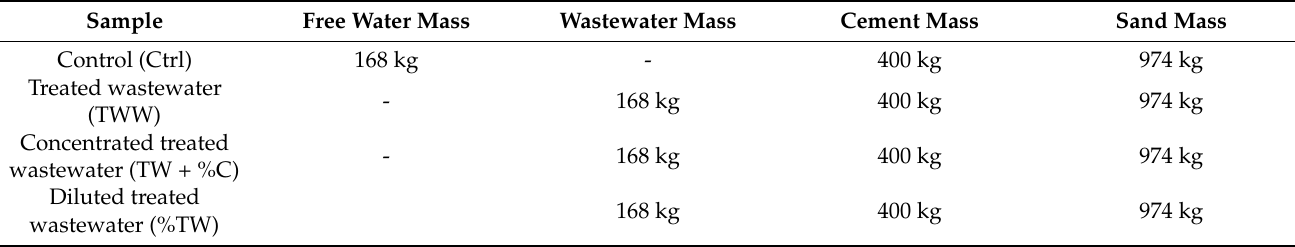
Table 4. The detail of concrete mixture designs.